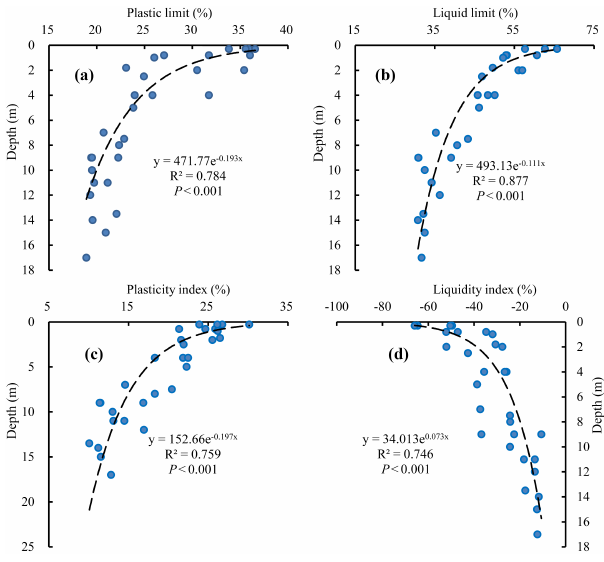
Figure 5. Relationship between soil Atterberg limits and soil depth. (a) Plastic limit, (b) liquid limit, (c) plasticity index and (d) liquidity